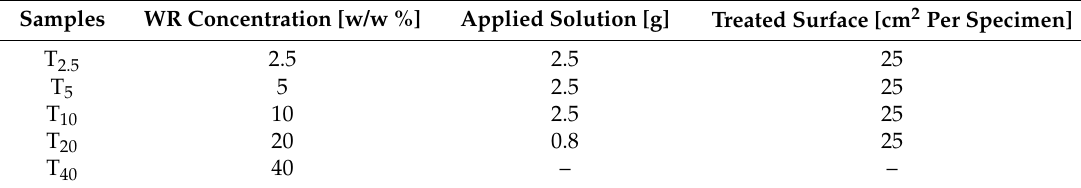
Table 1. Nomenclature of the treated samples and details of the